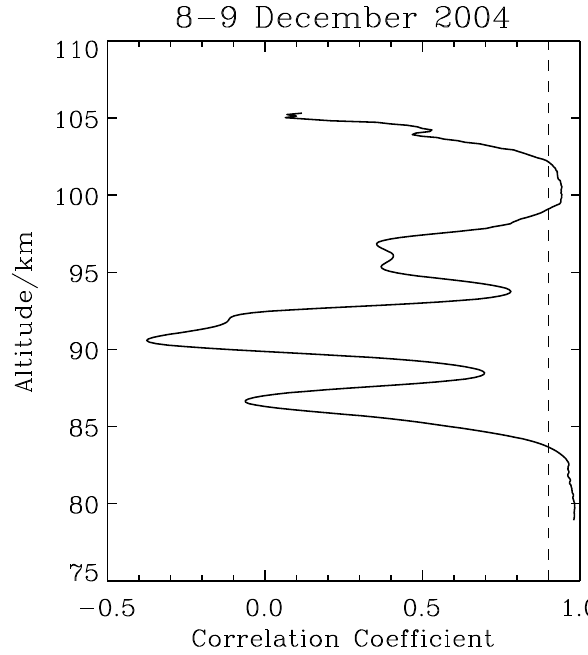
Fig. 10. Correlation coefficient between simultaneously observed Na and Fe densities versus altitude on the night of 8–9 Decem- ber 2004.